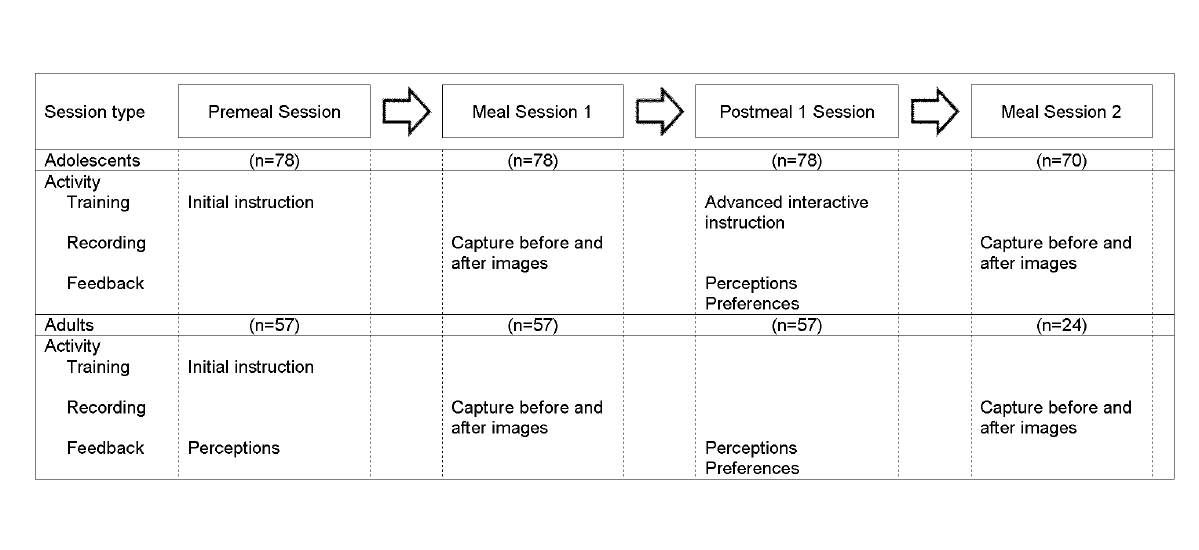
Figure 1. Study design, activities, and measures of participants using the mobile telephone food record. For 15 of the adolescent participants, meal session 2 was later in the same day. For the remainder of participants, meal session 2 occurred on a different day. Adult participants were offered dessert as a separate course. For meal session 1, 39 selected dessert, and for meal session 2, 15 selected